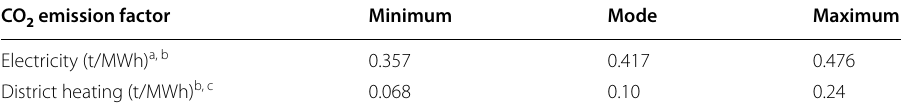
Table 8 CO emission factors for district heating and electricity 2